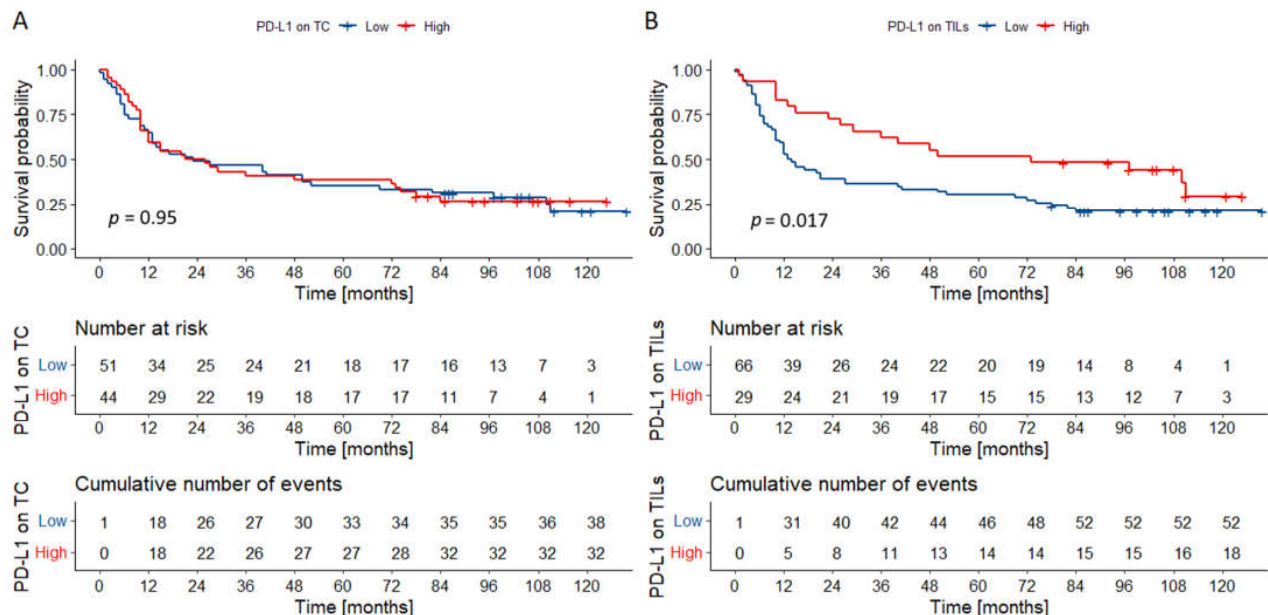
Figure 3. Kaplan–Meier curves for overall survival according to PD-L1 expression on TCs ( A ), and TILs ( B ). PD-L1 expression on TCs had no impact on the outcomes in the whole cohort. High PD-L1 expression on TILs was associated with superior overall survival. p values were calculated with the log-rank test. Abbreviations: TC—tumor cells; TILs—tumor-infiltrating lymphocytes.